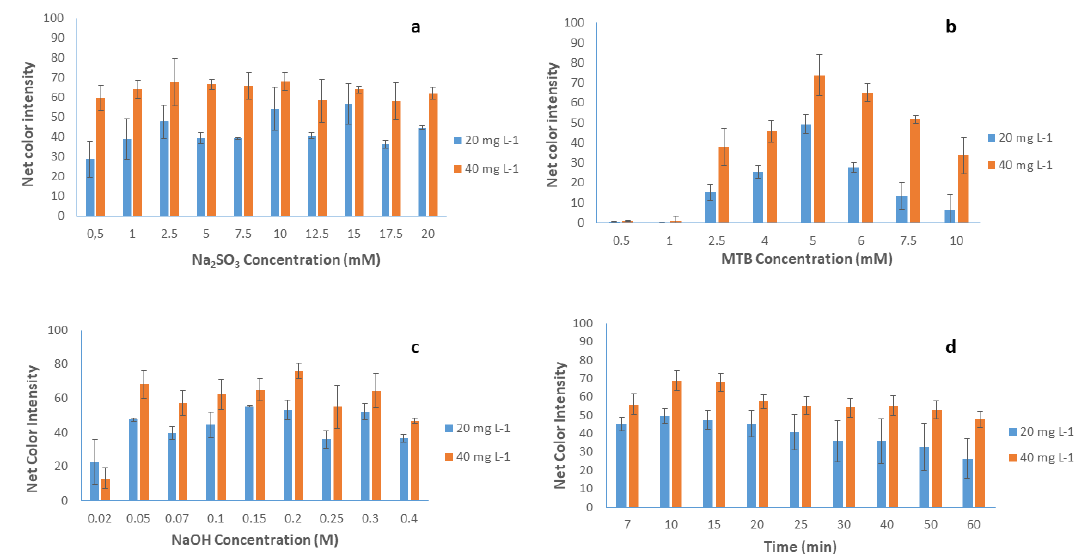
Figure 3. Optimization of ( a ) Na 2 SO 3 concentration (Ca 2+ 20 and 40 mg L − 1 , NaOH concentration 0.2 mol L − 1 , MTB concentration 5 mM, reaction time 10 min), ( b ) MTB concentration (Ca 2+ 20 and 40 mg L − 1 , NaOH concentration 0.2 mol L − 1 , Na 2 SO 3 concentration 2.5 mM, reaction time 10 min), ( c ) NaOH concentration (Ca 2+ 20 and 40 mg L − 1 , Na 2 SO 3 concentration 2.5 mM, MTB concentration 5 mM, reaction time 10 min), and ( d ) reaction time (Ca 2+ 20 and 40 mg L − 1 , Na 2 SO 3 concentration 2.5 mM, MTB concentration 5 mM, NaOH concentration 0.2 M). Error bars are the standard deviation for n = 3.